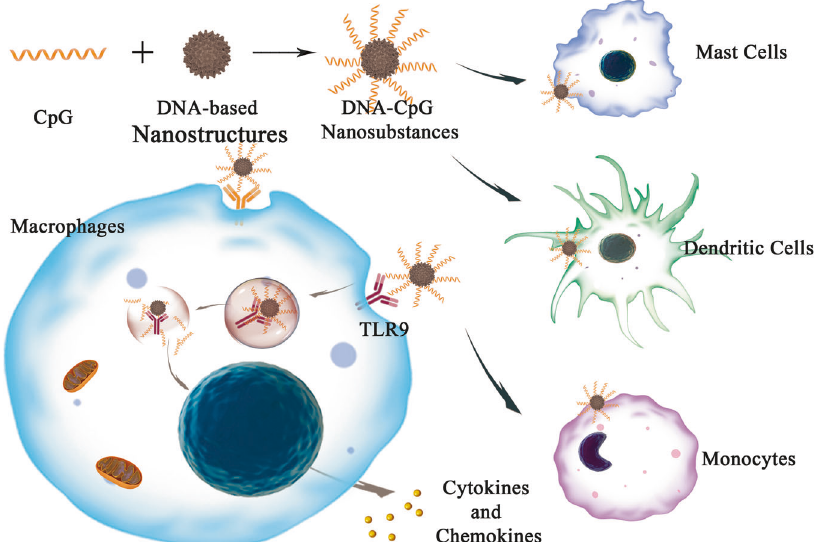
Fig. 4 DNA-based nanostructures on immunostimulatory reactions. CpG-modi fi ed DNA-based nanostructures could enter immune cells, including macrophages, mast, dendritic and monocyte cells through integrating with TLR9, which subsequently induce cascade reactions and promote the secretion of remarkable cytokines and